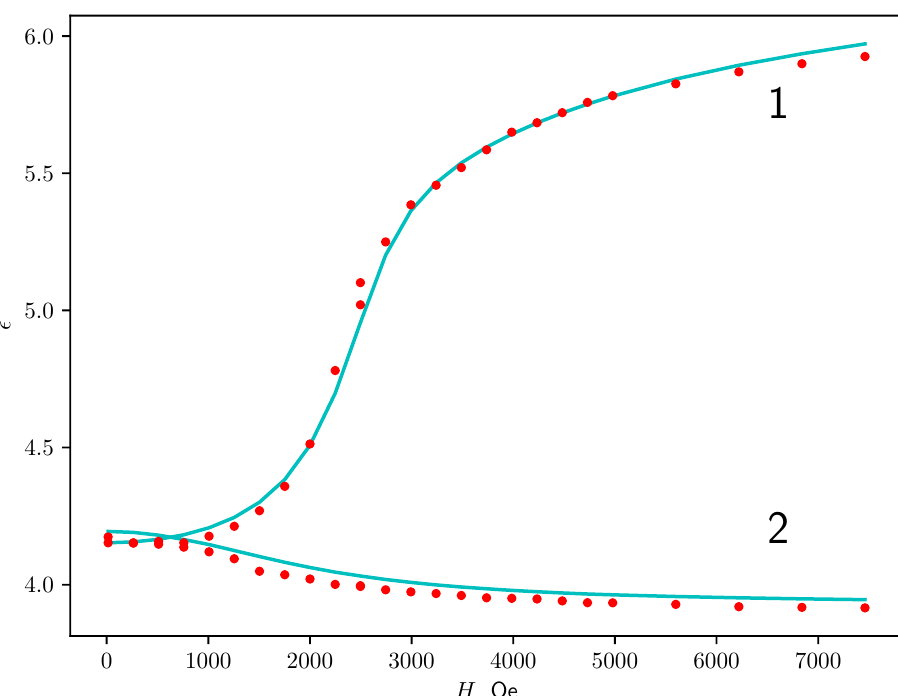
Figure 11. The dependencies of ¯ ε on H for Gd complex: experimental (dots) and theoretical (solid line). The line and the dots marked as 1 correspond to the case H ⊥ E . The line and the dots marked as 2 correspond to the case H (cid:107) E